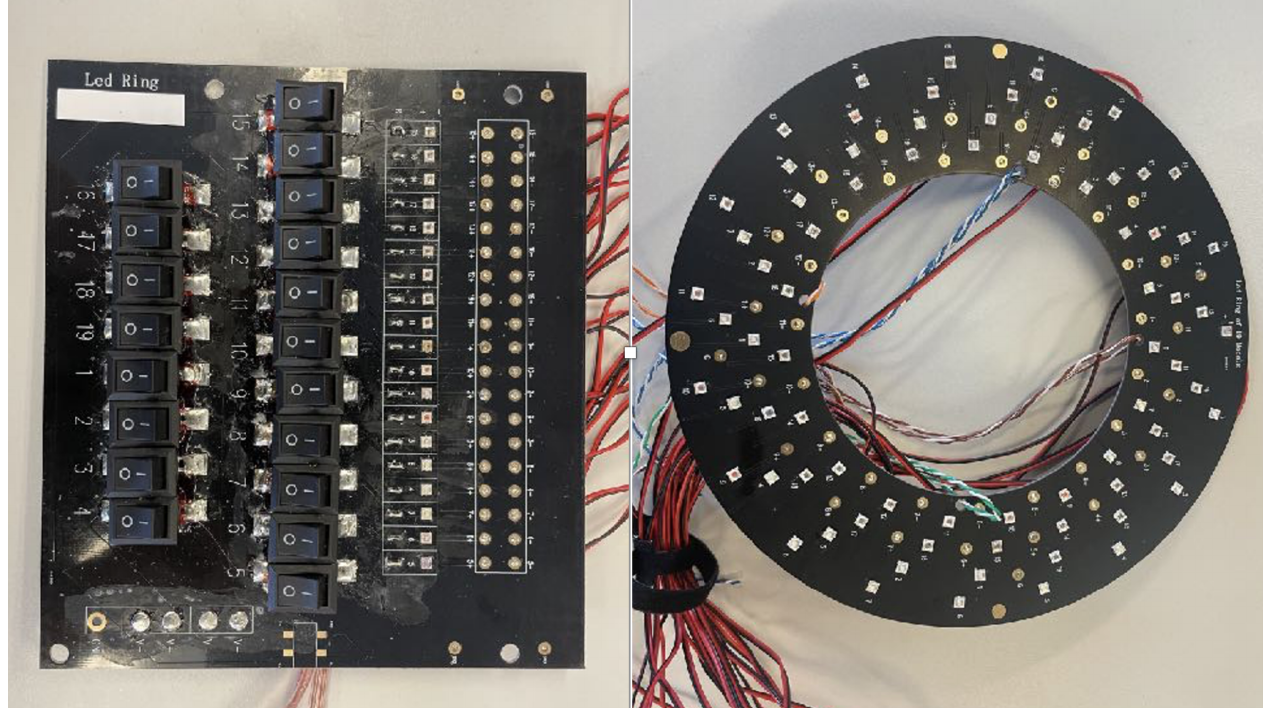
Figure 3. The LED illuminator. Light controller ( left ) and circular LED light panel ( right